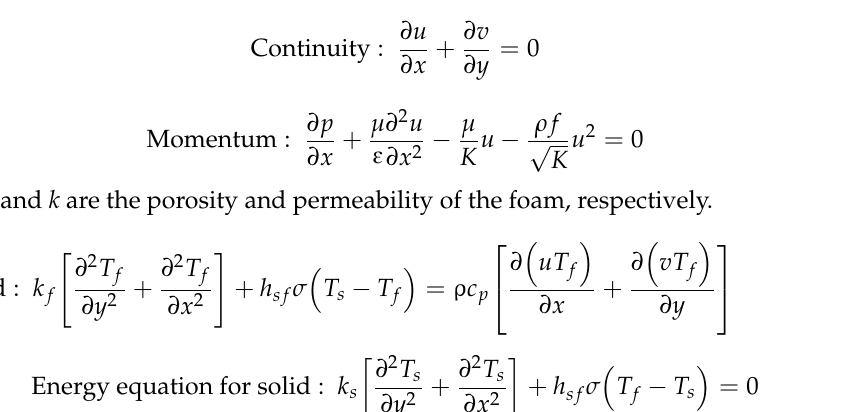
Figure 1. Solution domain for preliminary study.